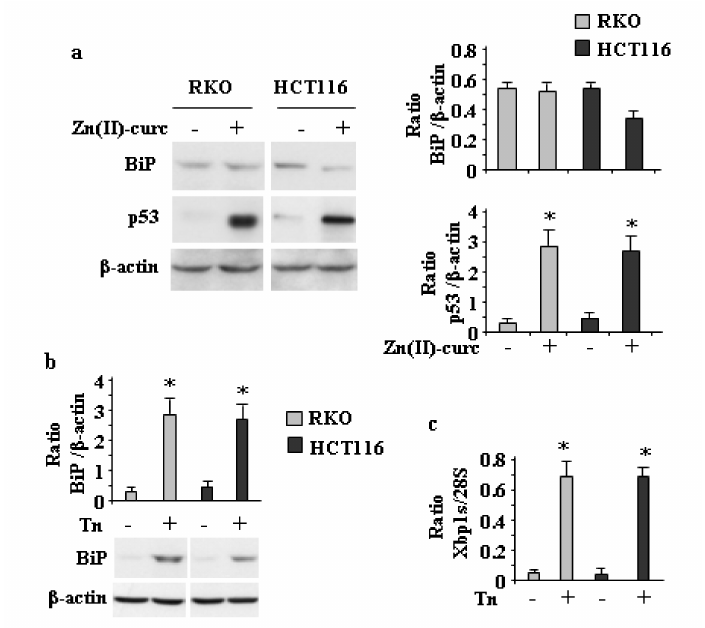
Figure 2. Zn (II)-curc does not a ff ect ER stress in wtp53-carrying cells. ( a ) (left panels) Western blot analysis of BiP and p53 protein levels in RKO and HCT116 cells treated with Zn(II)-curc (100 µ g / mL) for 24 h. Densitometric analysis (right panels) was performed using Image J software to calculate the ratio of BiP and p53 protein levels vs. β -actin. Histograms represent the mean ± SD of three independent experiments. * p ≤ 0.05. ( b ) Western blot analysis of BiP protein levels in RKO and HCT116 cells treated with Tunicamycin (Tn) (1 µ g / mL) for 4 h. (upper panel) Densitometric analysis was performed using Image J software to calculate the ratio of BiP protein levels vs. β -actin. Histograms represent the mean ± SD of three independent experiments. * p ≤ 0.05. ( c ) Total mRNA was extracted from RKO and HCT116 cells treated with Tunicamycin (Tn) for 24 h, and Xbp1 gene expression was assayed by the PCR of reverse-transcribed cDNA. Densitometric analysis was performed using Image J software to calculate the Xbp1s / 28S ratio. Histograms represent the mean ± SD of three independent experiments. * p ≤